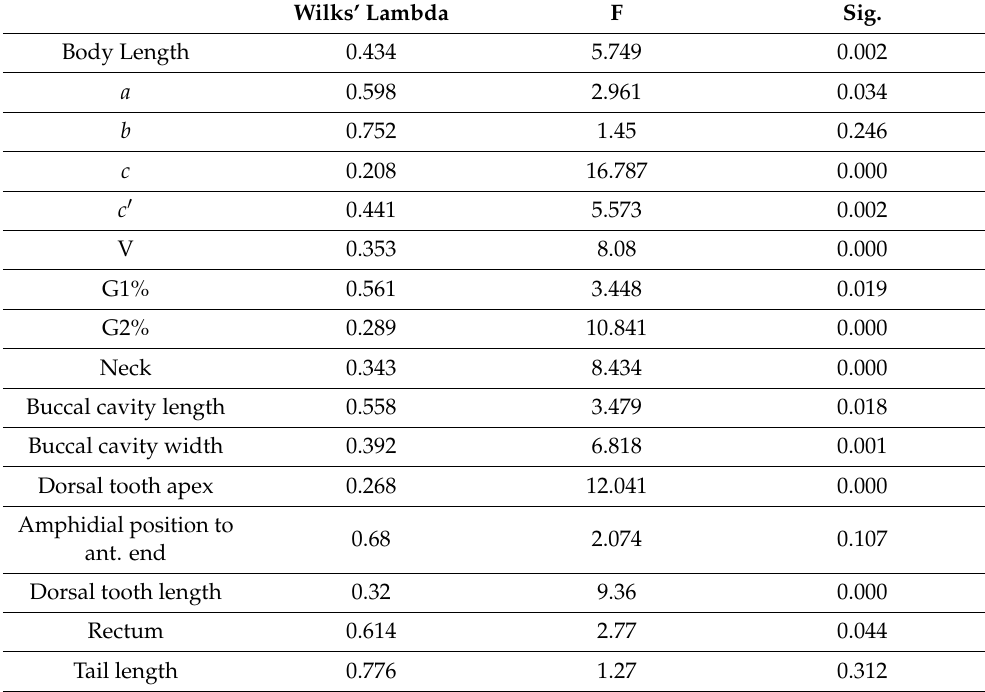
Table 3. Discriminant functions for the morphometric variables of six Mylonchulus species from Iran. Wilks’ Lambda Sig.